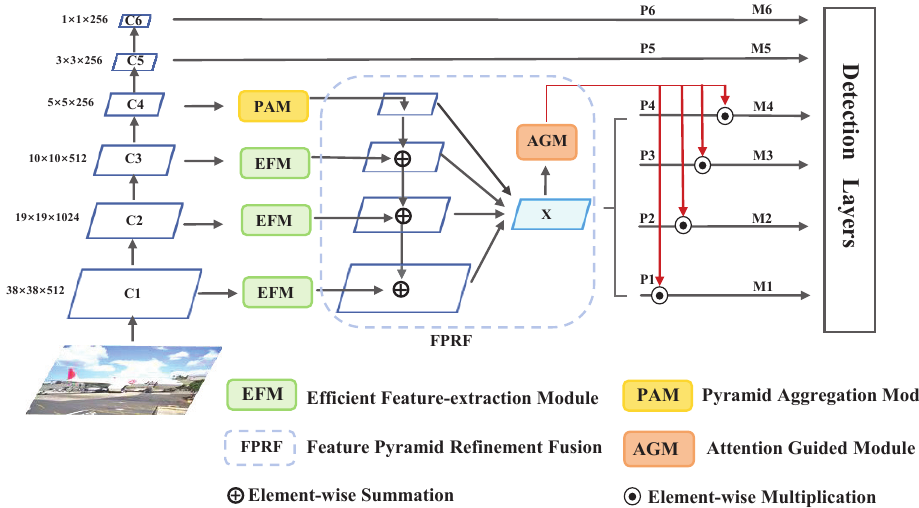
Figure 1. Overall architecture of the proposed FCSSD. Our approach consists of four components: a standard SSD network; feature-enhancement components: the efficient feature-extraction module (EFM) and pyramidal aggregation module (PAM); the feature pyramid refinement fusion (FPRF) process X ; the attention-guided module (AGM). Here, C i denotes the feature map extracted from the CNN backbone, P i denotes the corresponding pyramid levels in the FCSSD, and M i is the final output of every level. An input image is first downsampled and passed through the EFM and PAM to produce features with more semantic and rich global contextual information. The FPRF uses an FPN-style design to refine the previous features for fusion. The AGM adopts a channel attention scheme to extract channel-balanced weights, and it reduces the aliasing effects of the fused